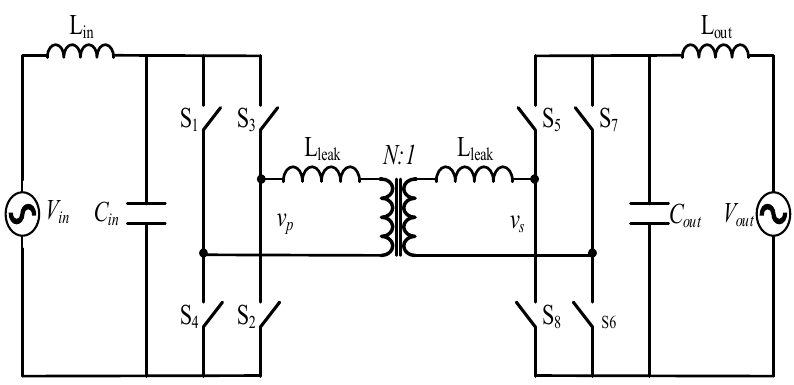
Figure 2. Detailed single stage SST topology [17].